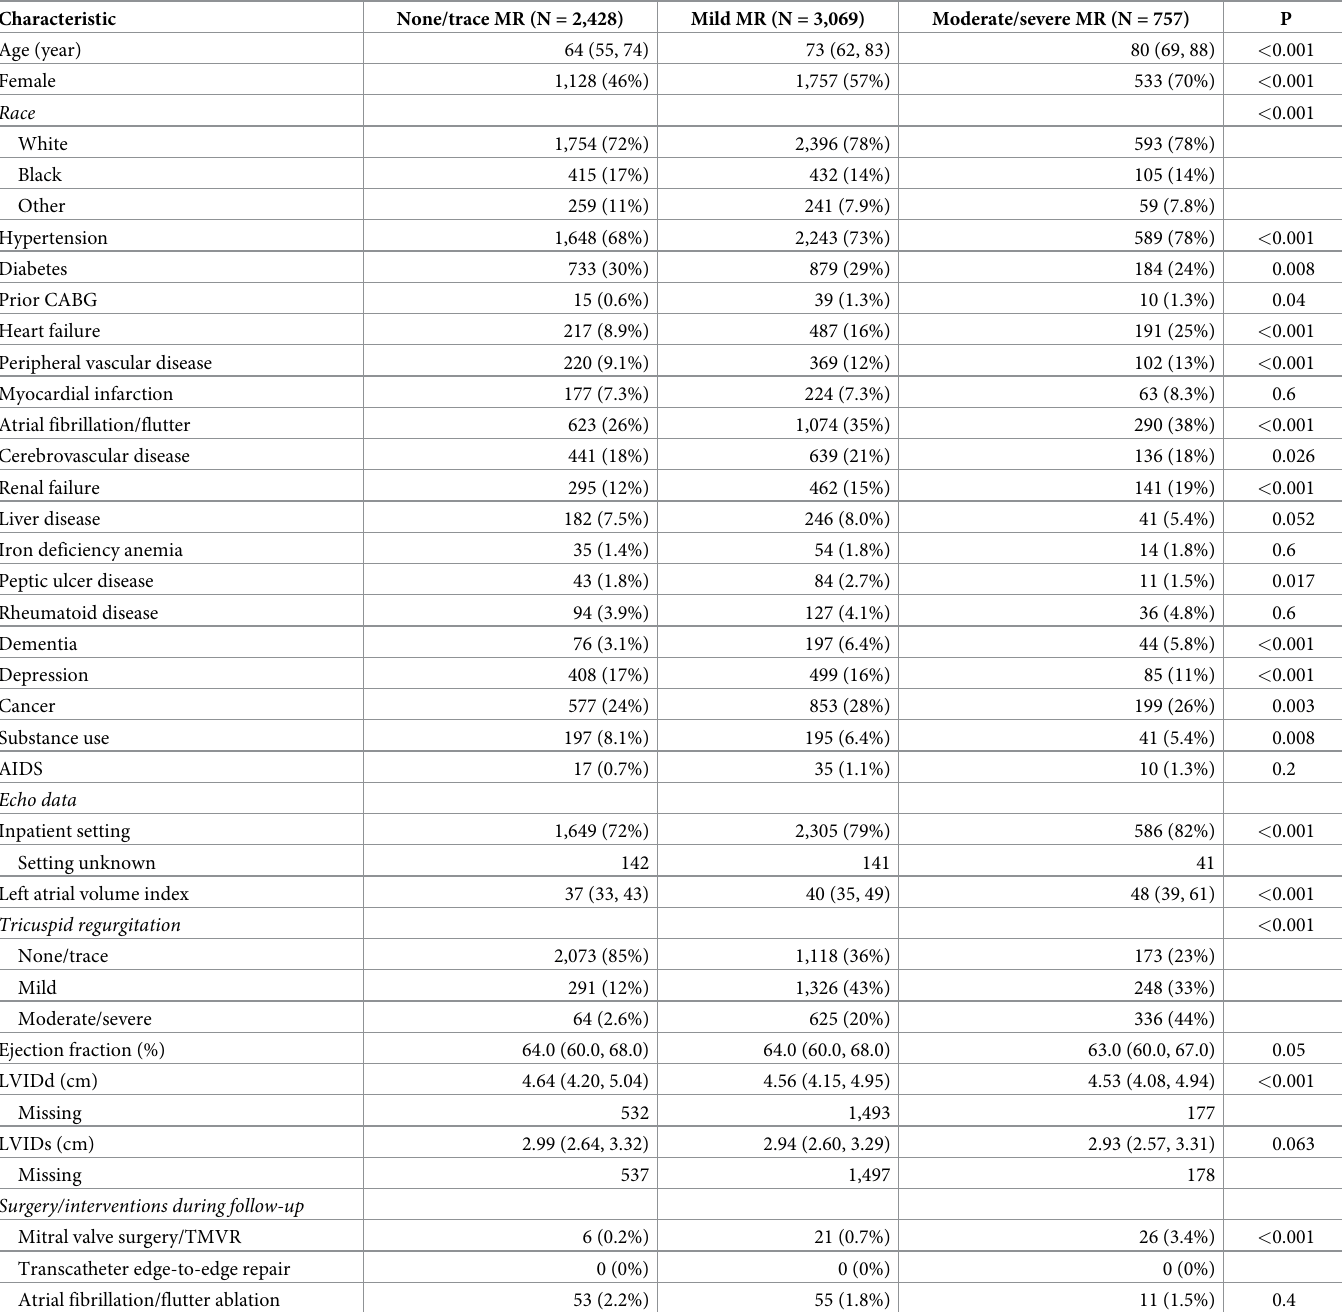
Table 2. Characteristics of patients with atrial dysfunction by the SMR